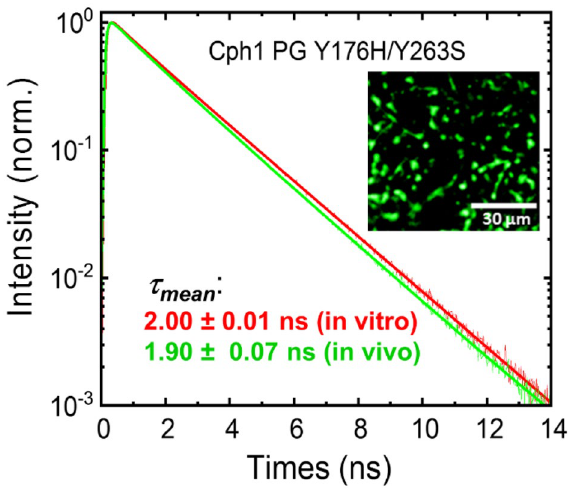
Figure 5. Characterization of Cph1 PG Y176H/Y263S in vivo using FLIM. Fluorescence decay curves in vitro and in vivo are shown together with the mean fluorescence lifetimes. The inset shows the FLIM image of E. coli cells expressing Cph1 PG